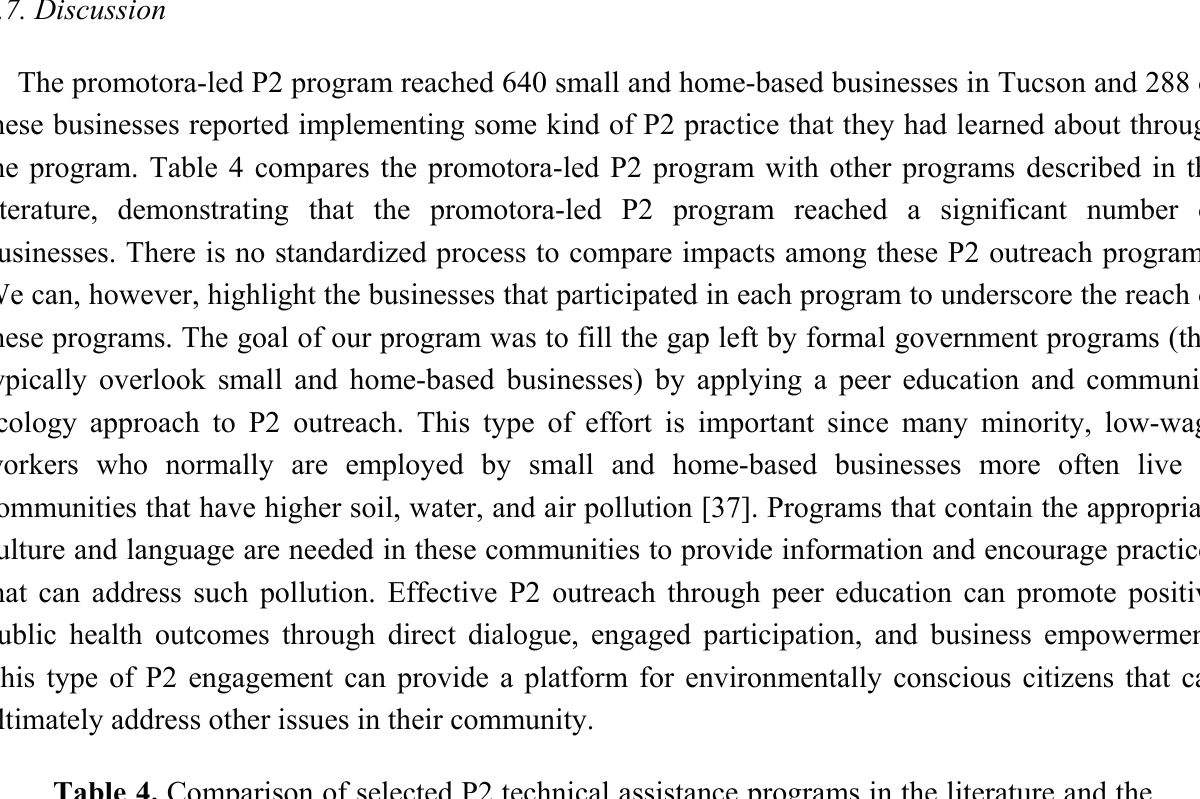
Table 4. Comparison of selected P2 technical assistance programs in the literature and the promotora-led P2 program in Tucson, AZ,